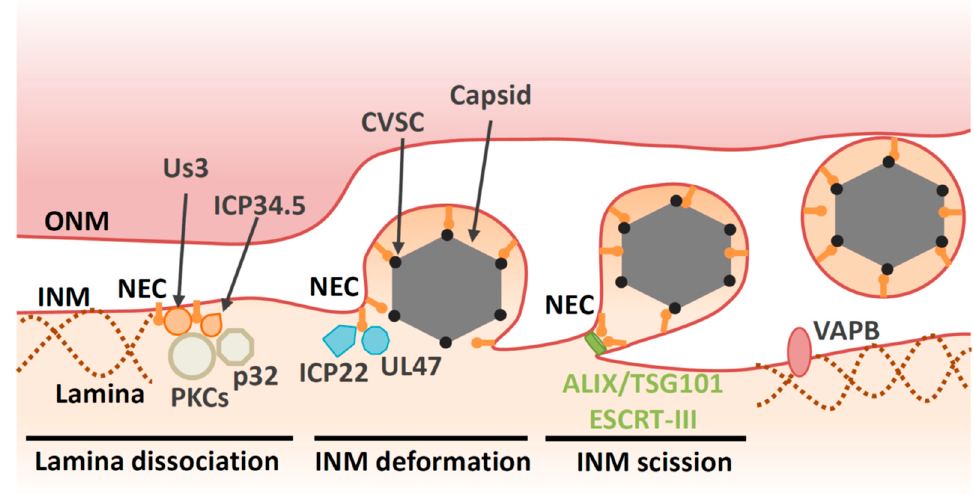
Figure 2. Multiple proteins are involved in primary envelopment of HSV-1 capsids. NEC and kinases (e.g., PKCs and Us3) induce lamina dissociation to allow capsid recruitment to the INM. ICP34.5 and p32 contribute to the recruitment of PKCs. The NEC is responsible for capsid recruitment and mediates budding by assembling into a hexagonal lattice. CVSC decorates vertices of DNA-filled nucleocapsid and promotes nuclear egress through interaction with the NEC. Viral proteins (e.g., UL47 and ICP22) and cellular protein VAPB regulate primary envelopment through as-yet unidentified mechanisms. The NEC recruits ESCRT-III via ALIX to pinch off primary virions from the INM.